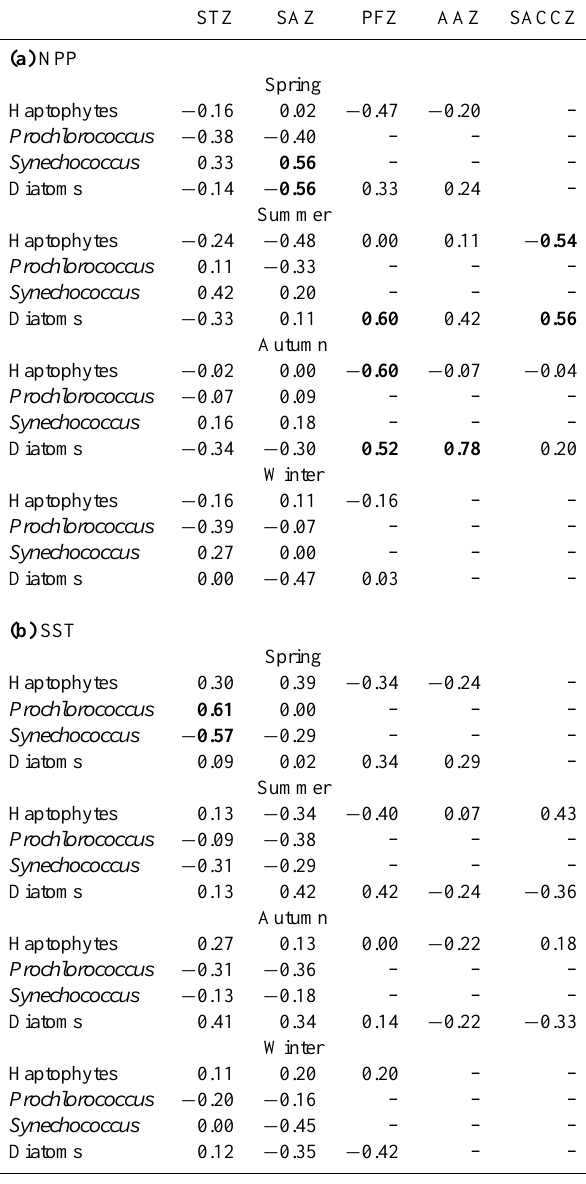
Bold numbers denote statistical significance at the 95% confidence level. In all cases, number of samples is 10.